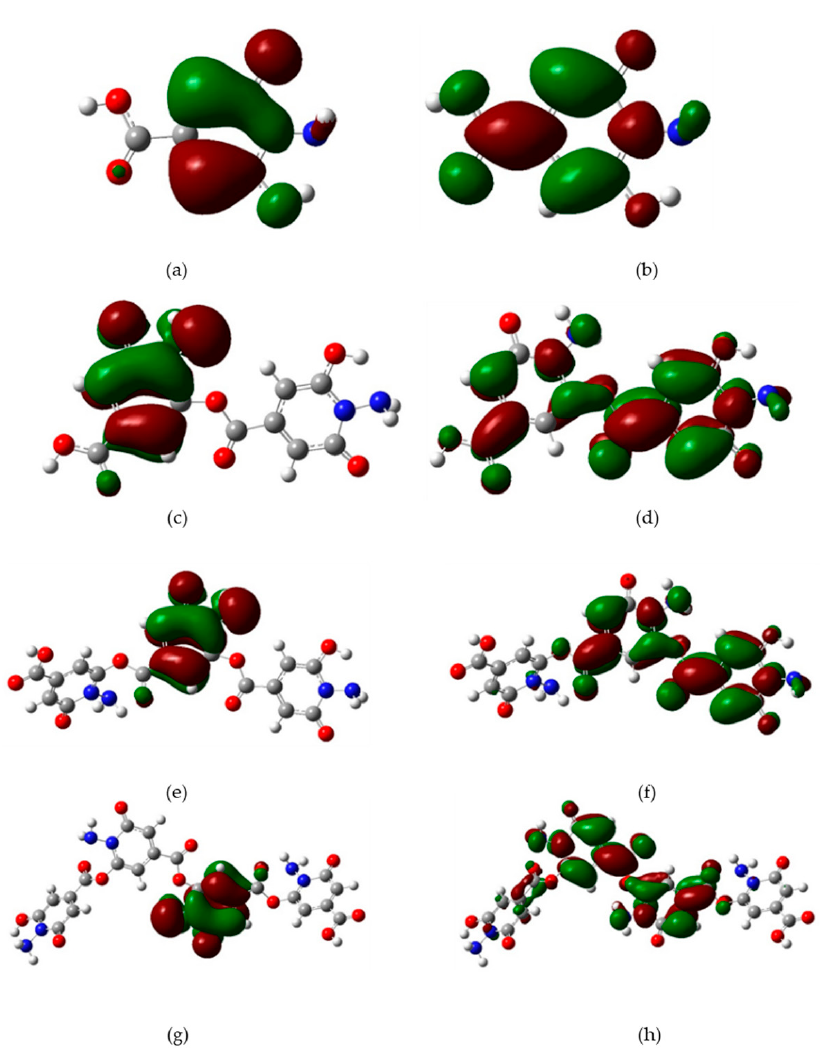
Figure 9. MOs of the HOMO–LUMO states (HOMO on the left and LUMO on the right) for the Hy-CD system ( a , b ) and its O-Polymer derived: Hy-CD-O-Pol-2 ( c , d ), Hy-CD-O-Pol-3 ( e , f ), Hy-CD-O-Pol-4 ( g , h ). The isocontour value is 0.02 au (H atom—white sphere, C atom—grey sphere, N atom—blue sphere, O atom—red sphere).